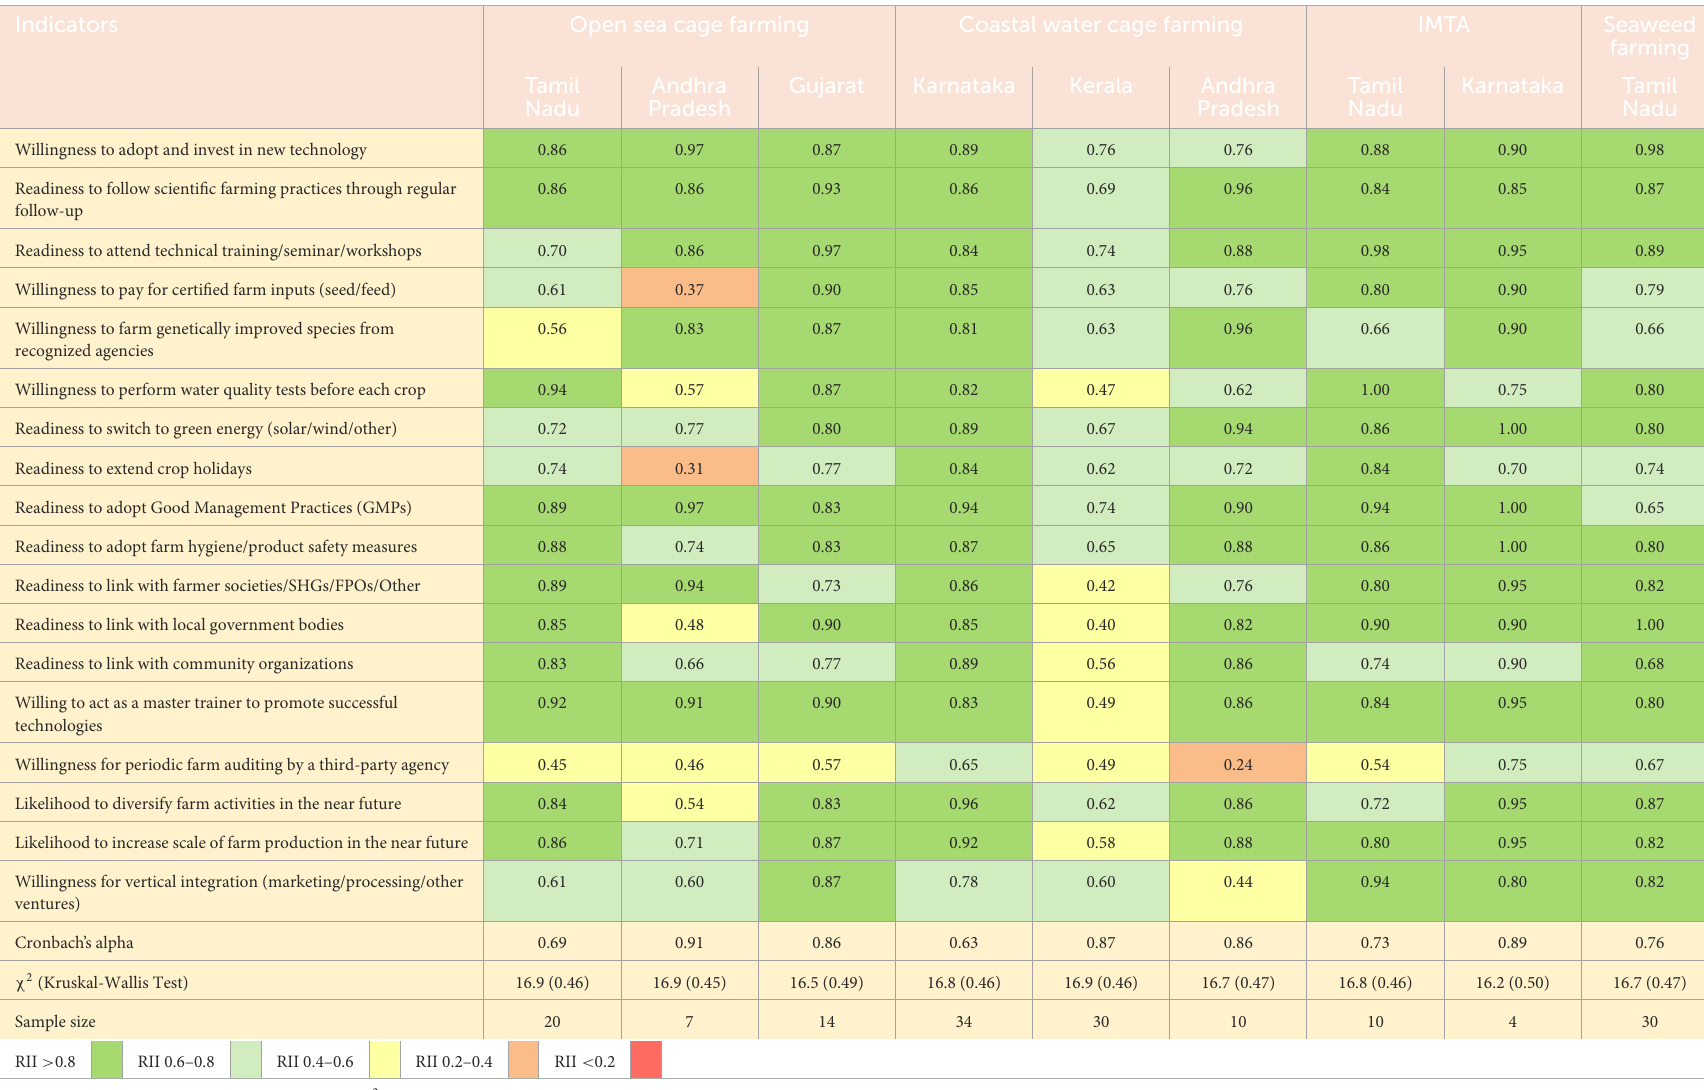
TABLE 5 Estimates of Relative Importance Index (RII) indicating the willingness to embrace standard sustainable practices in the future by the sample respondents practicing the selected mariculture enterprises (over and above existing